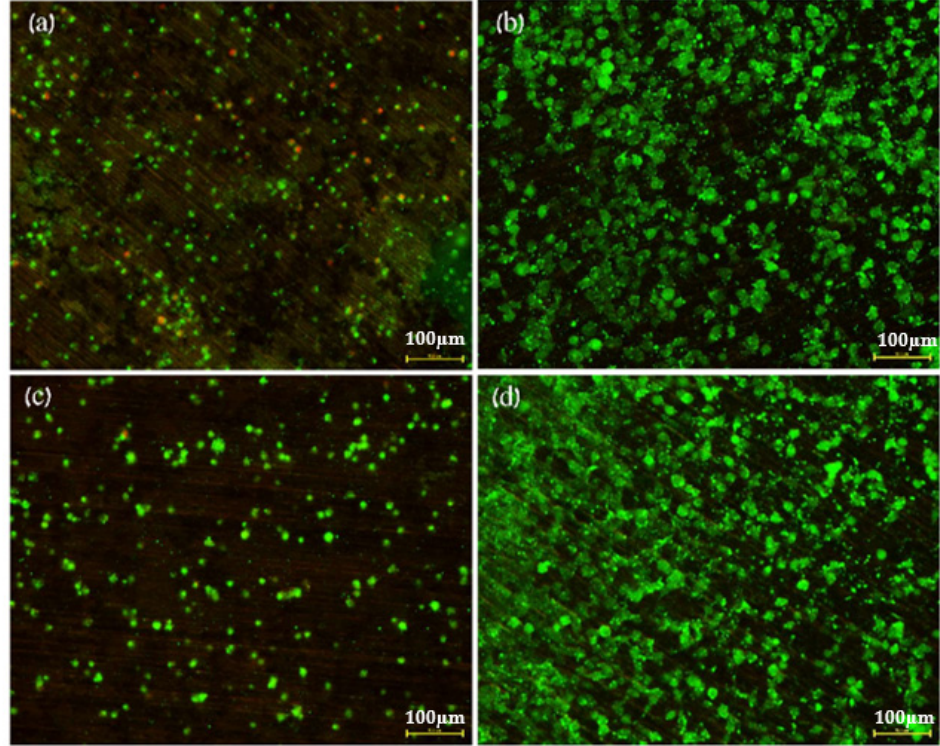
Figure 12. Typical fluorescence images of live (green) and dead (red) 4T1 cells attached to Zn-2%Fe- 0.6%Ca and to Ti6Al4V, respectively ( a , b ) after 24 h incubation; ( c , d ) after 48 h incubation.